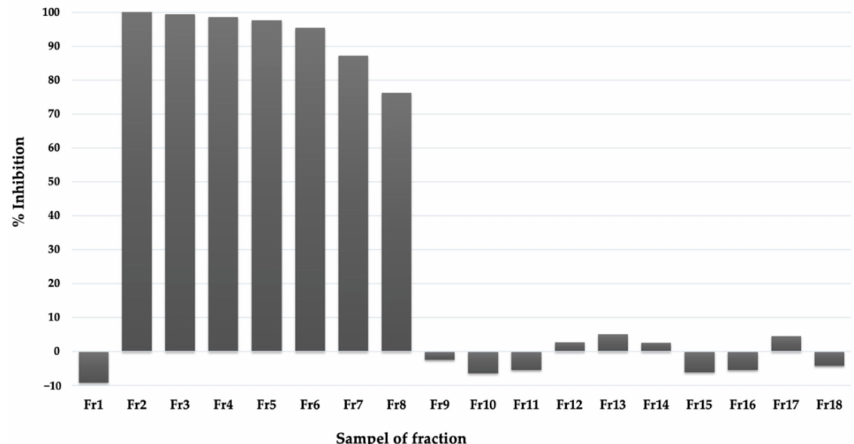
Figure 5. Inhibitory activity of fractions of active extracts eluted by mixed chloroform-methanol solvent from silica gel column chromatography against Pf MQO (see text for